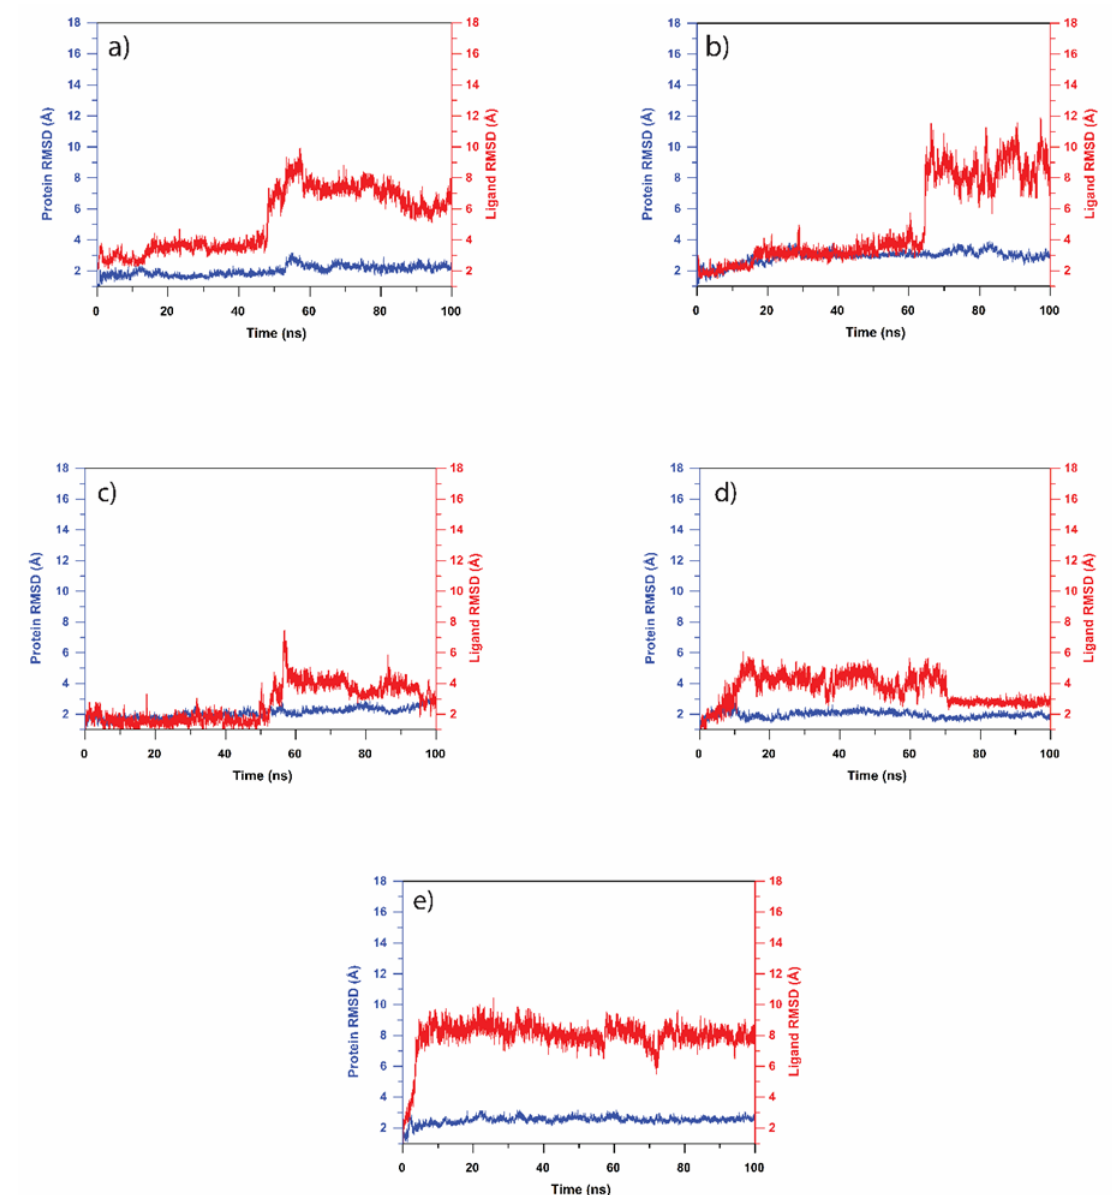
Figure 4. RMSD plots for natural compounds: ( a ) Luteolin 7,3 ′ -diglucuronide, ( b ) Luteolin 7-glucu- ronide-3 ′ -glucoside, ( c ) Plantagoside, ( d ) Narcissoside, ( e ) (alphaE,8S,9R)-N-(3,4-Dihydroxy- phenethyl)-8-[(3,4-dihydroxyphenethyl)carbamoyl]-9-(1,3-benzodioxole-5-yl)-3aalpha,7aalpha- ethano-1,3-benzodioxole-5-acrylamide. (Ligand RMSD is in red, and Protein RMSD is in blue.)